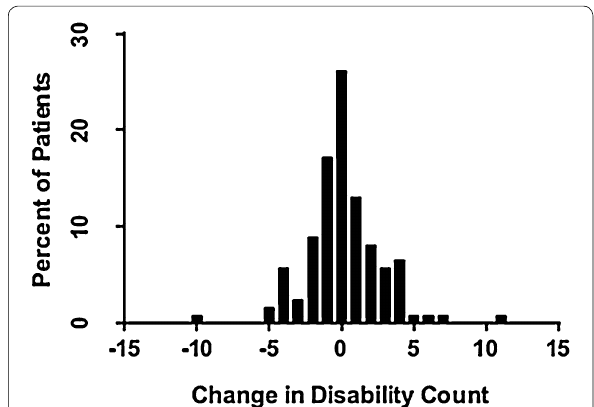
Fig. 2 Change in disability counts from ICU admission to follow- up for 122 patients completing BADL/IADL instruments. Legend For changes in disability counts, positive values indicate increased